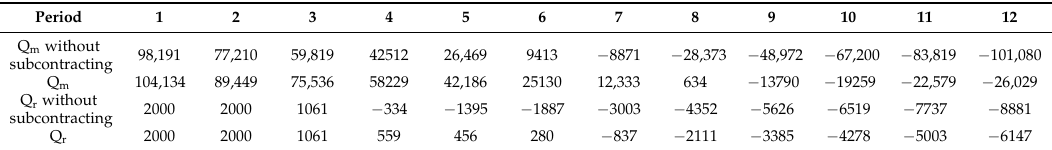
Table 2. Amount of emitted carbon during the different process.